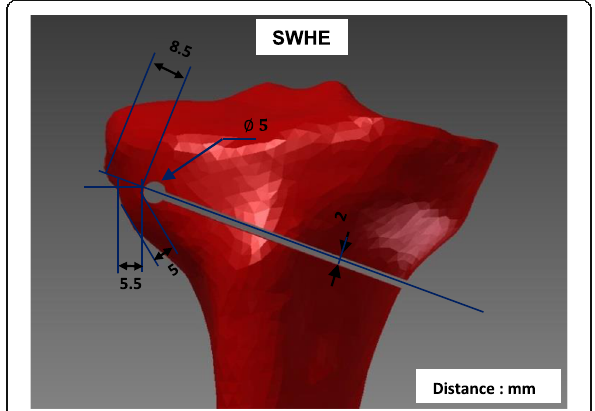
Fig. 2 Specimen SWHE: Specimen with the drilled hole as an extension of the osteotomy cut. The osteotomy cut was realised as for specimen SNH (Fig. 1) and the drill hole of 5 mm diameter was located about 20 mm distally to the tibial plateau and 6 mm medially to the lateral